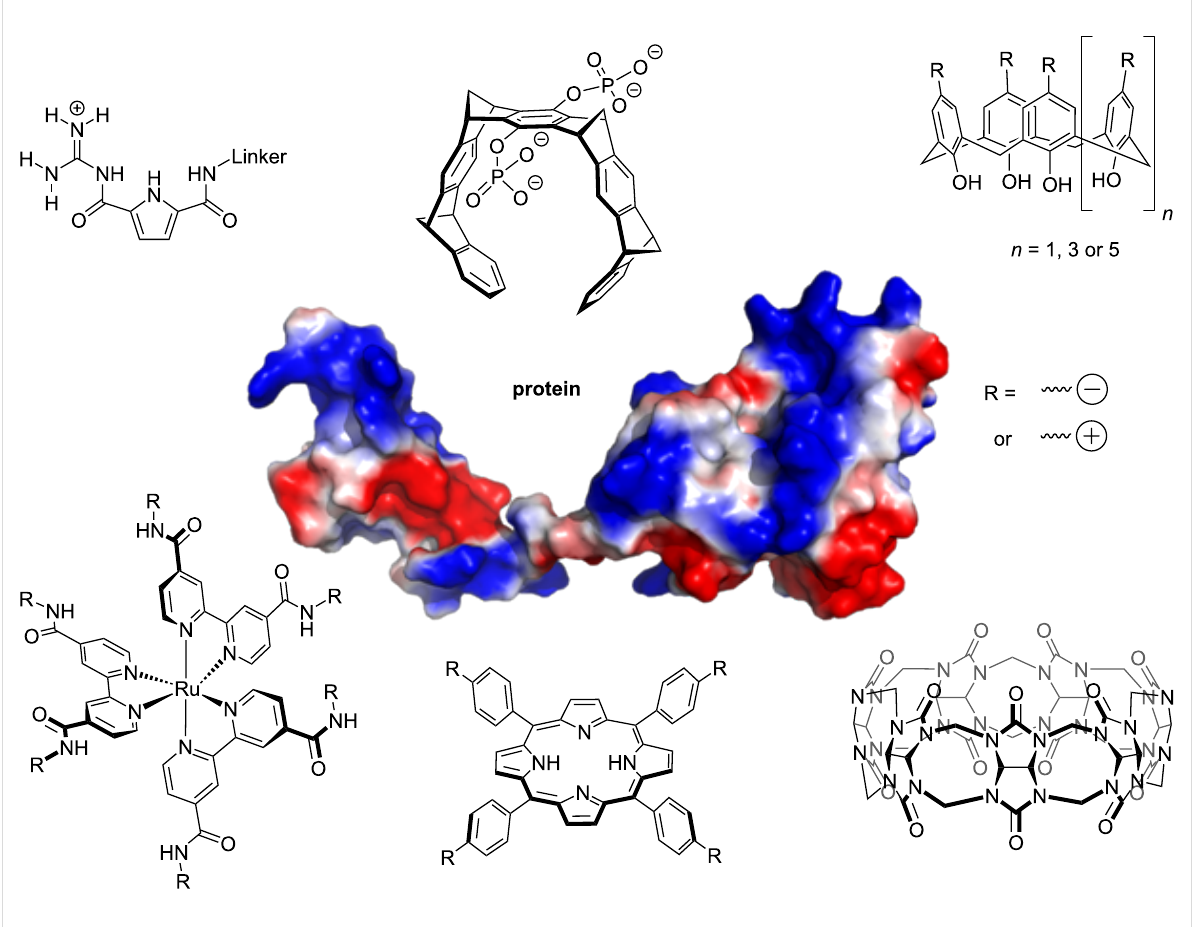
Figure 1: Ligands targeting charged areas on protein surfaces discussed in this review. The protein shown as example is h Pin1 (pdb 1NMV, [75]). The guanidiniocarbonylpyrrole motif (GCP, top left) recognizes the carboxylate groups of aspartate or glutamate residues by forming an extended H-bonding network [41-46]. Supramolecular tweezers (top center) thread lysine or arginine side chains into their aromatic cavities [5-18]. Calixarenes (top right, [19-40]), Ru II (bpy) 3 complexes (bottom left, [61-63]) and porphyrins (bottom center, [52-60]) can be functionalized with either multiple acidic or basic groups to target charged areas of either polarity on a protein surface. Cucurbiturils (bottom right, [47-51]) recognize methylated lysines and arginines by binding their methylated head groups inside the